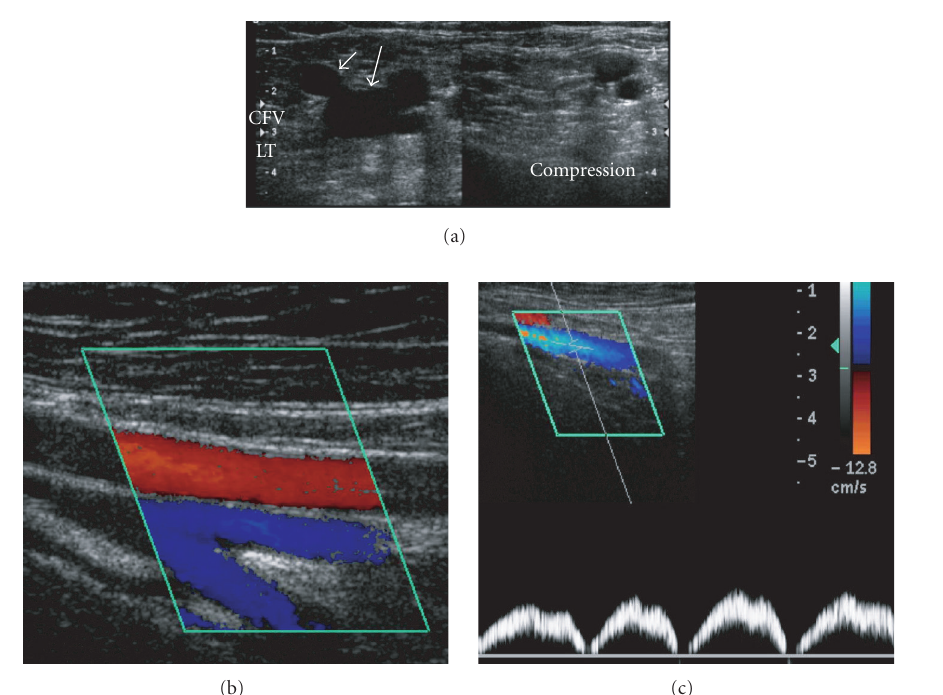
Figure 2: Normal vein. (a) Sonolucent lumen, easily compressible with a slight pressure exerted by the probe. Left side: before compression; right side: during compression; only the arteries remain visible. Large arrow: common femoral vein (CFV); short arrow: great saphenous vein. (b) Flow in femoral artery and veins at the level of the bifurcation. (c) Centripetal nonpulsatile flow in femoral vein, with respiratory phasicity.